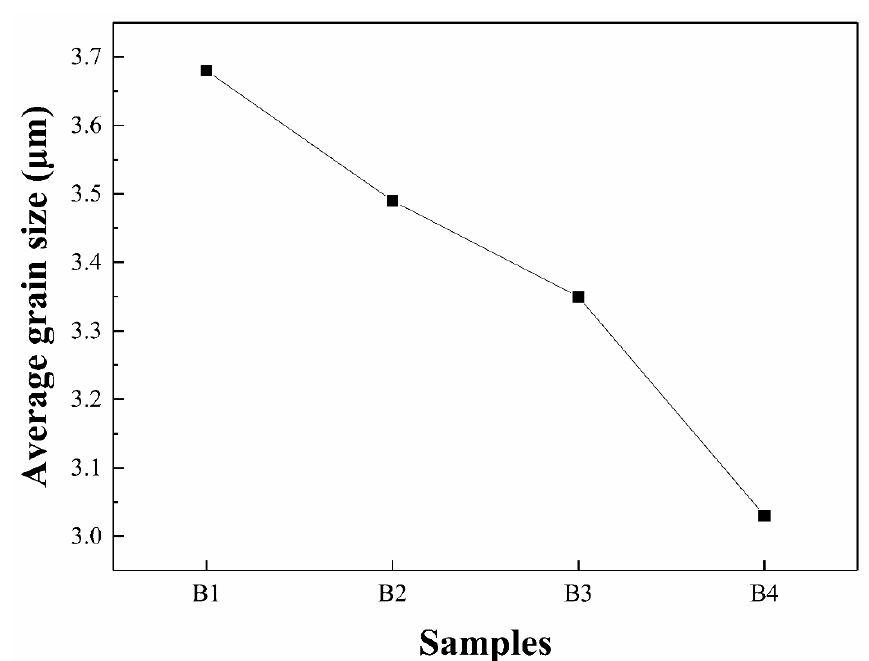
Figure 5. Alumina grain size distribution map of samples B1 ( a ), B2 ( b ), B3 ( c ), and B4 ( d ).